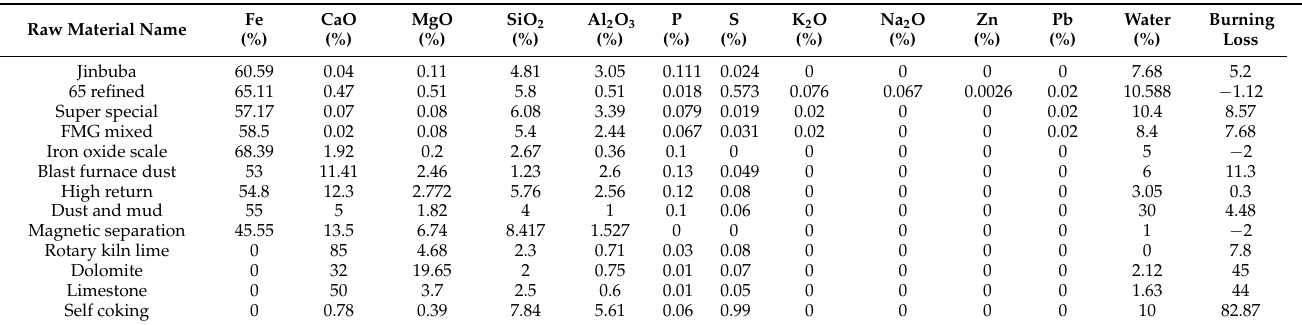
Table 3. Table of basic properties of sintering